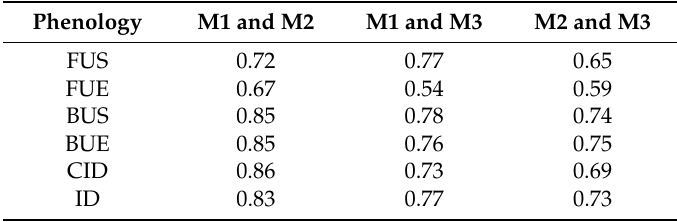
Table 4. Correlation (R 2 ) between lake ice phenology indices from different approaches.